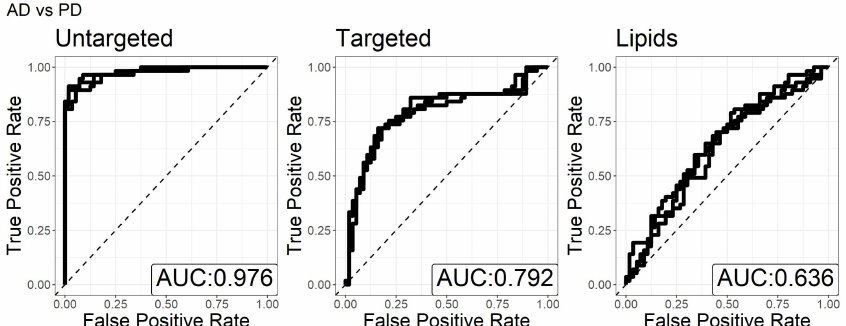
Figure A6. ROC curves displaying leave one out predictive accuracy of models including age and sex rather than detrending each metabolite. Age and sex are not penalized in the elastic net procedure to reflect the known associations between age and sex with AD and PD. As expected, we generally find that the predictive performance of these models is slightly better than those presented in the main analysis.